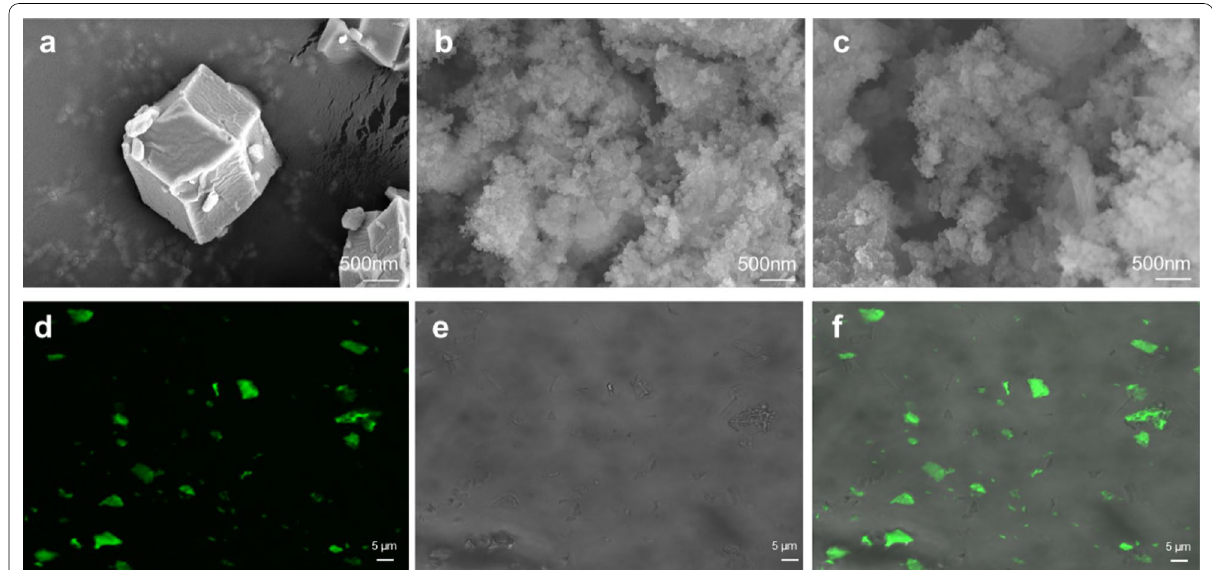
Fig. 1 SEM images of MAF-7 a , Lac@MOM b , and Lac/MNP@MOM c ; Confocal laser scanning micrographs showing the fluorescence d , bright field e , and overlay f images of